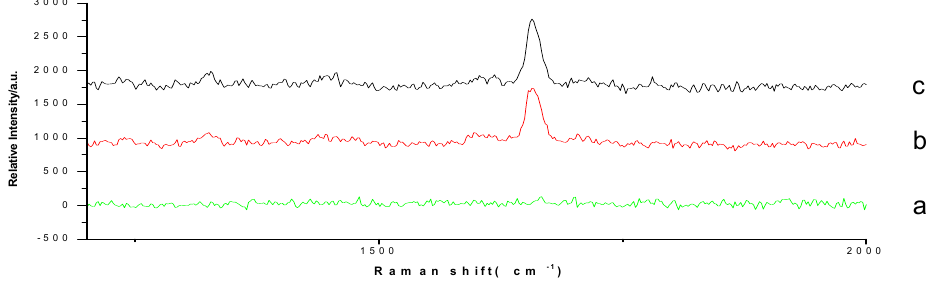
Figure 6. TLC-SCRS of prednisone (A) ( a : simulated negative sample; b : simulated positive sample; and c : reference substance of prednisone).